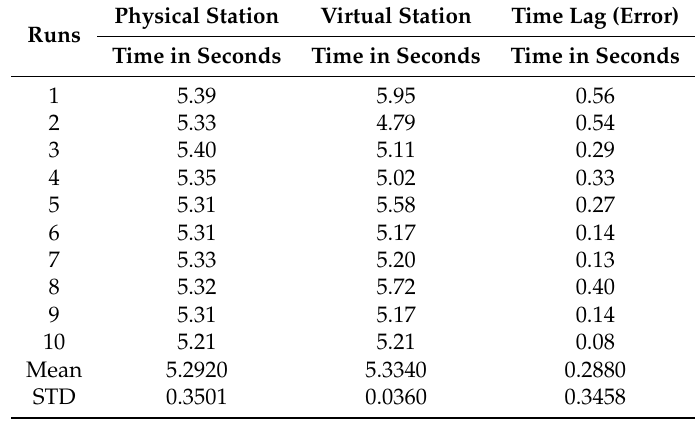
Table 1. Motion study experiment data.